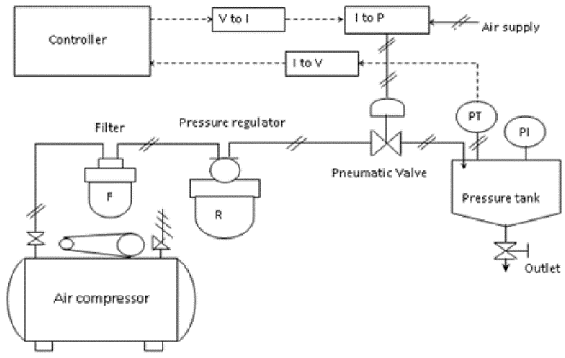
Figure 1. Pneumatic pressure control, schematic diagram.